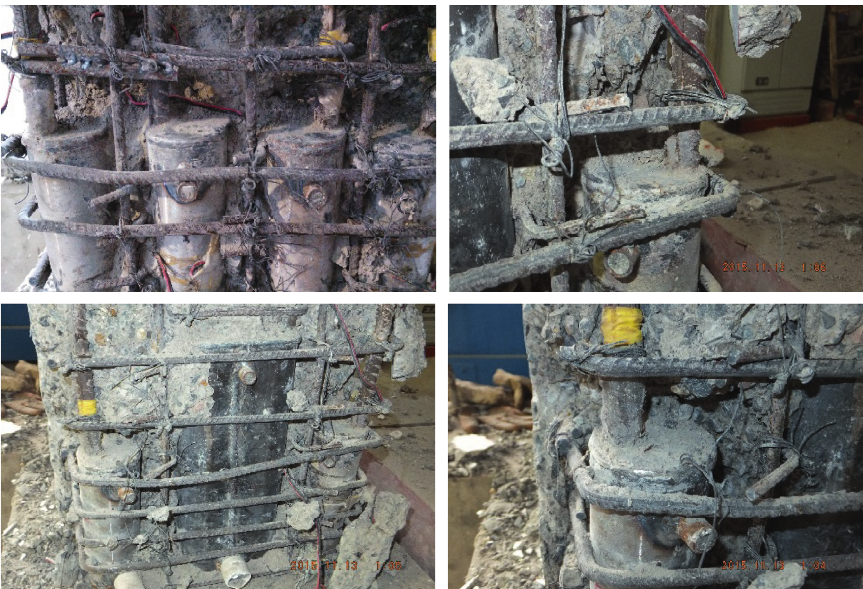
Figure 11: Pictures of joint regions after concrete being chiseled away.